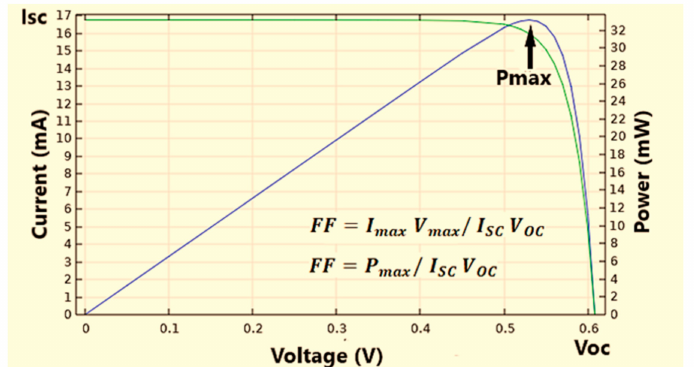
Figure 7. (I-V) and (P-V) characteristics of a solar cell under illumination.